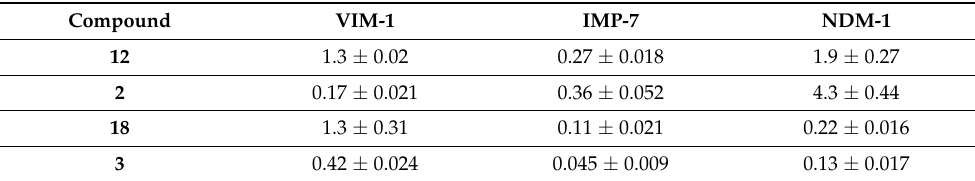
Table 1. IC 50 values ± SD [ µ M] of compounds 2 , 3 , 12 , and 18 obtained in enzymatic fluorescence- based assay with recombinant β -lactamases VIM-1, IMP-7, and NMD-1. All measurements were performed in at least triplicates.